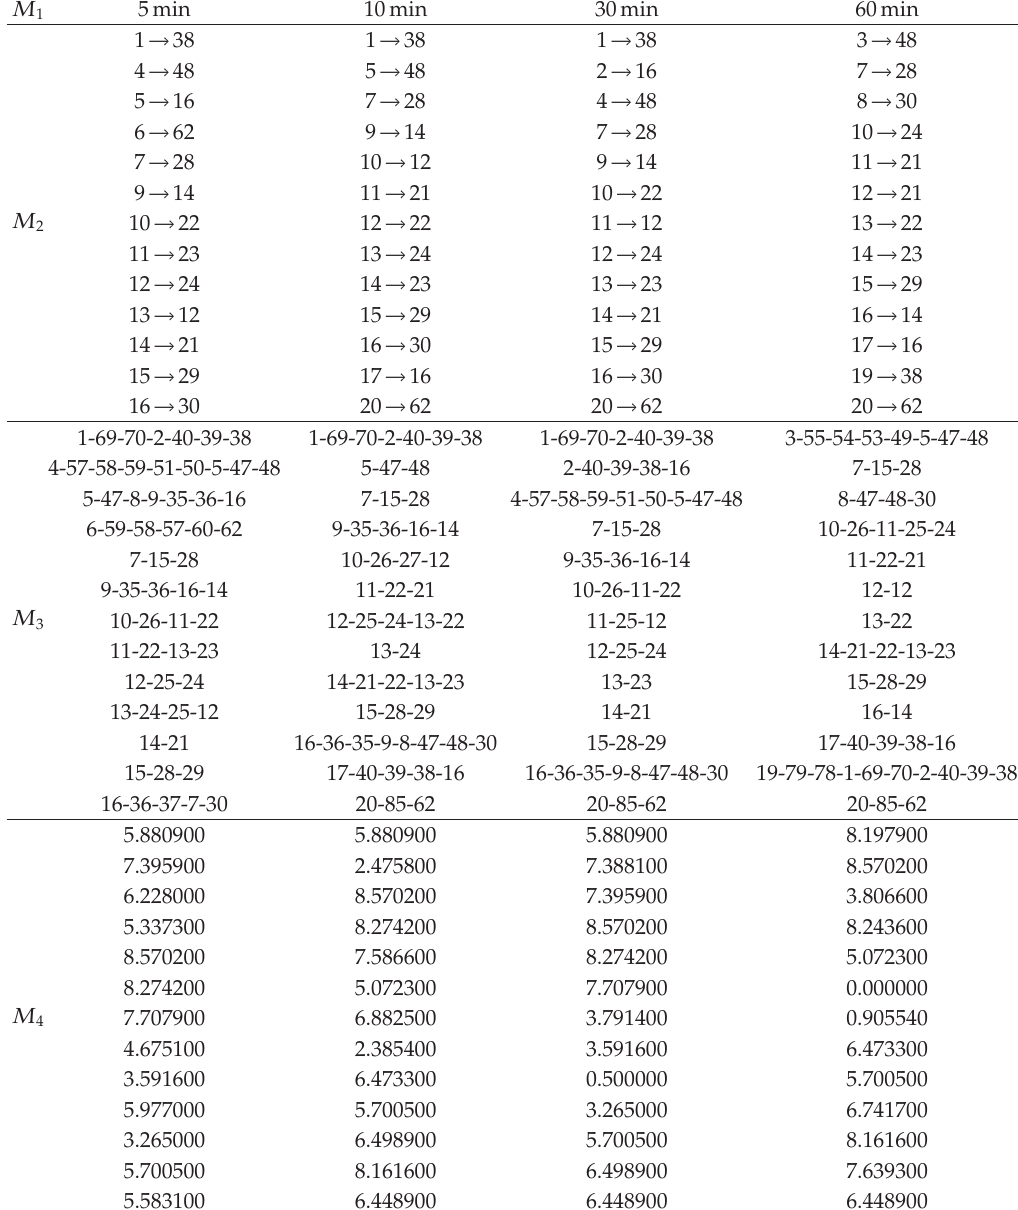
Table 6: The optimal dispatch project of TPPSP with T pq (cid:8) 5 , 10 , 30 ,